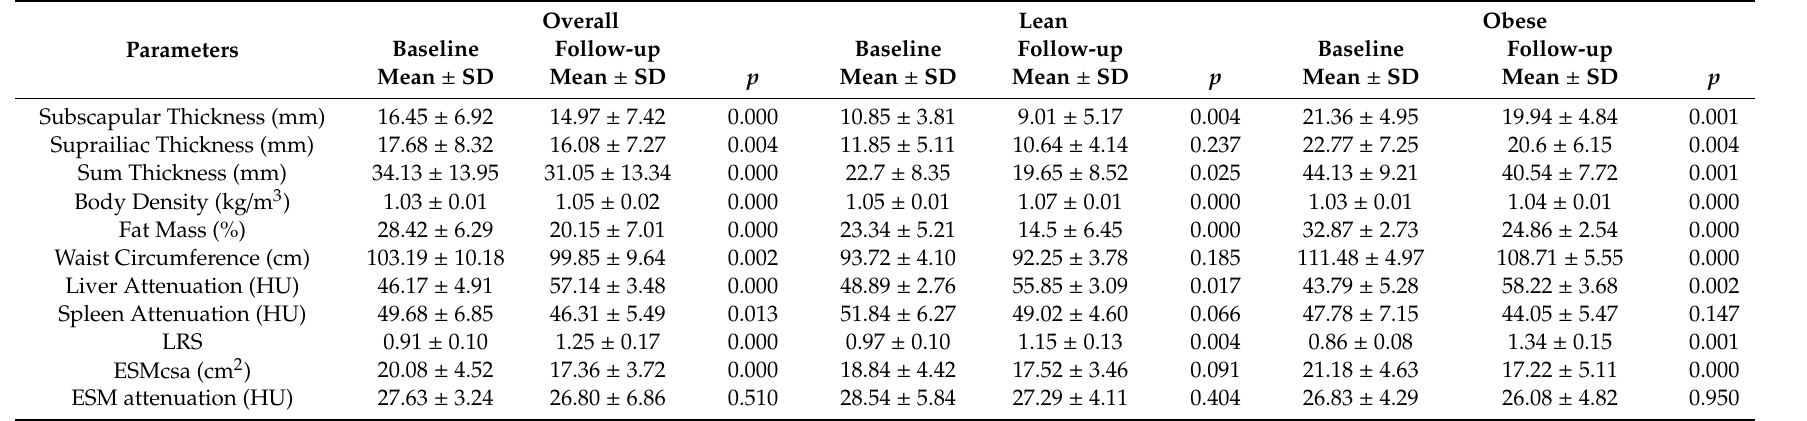
Table 2. Comparison between baseline and follow-up in each